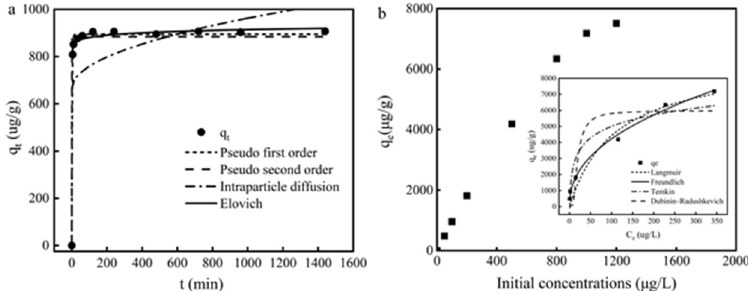
Figure 6. ( a ) Effects of the contact time and pseudo-first-order, pseudo-second-order, intraparticle diffusion, and Elovich kinetic models for the adsorption of Cd (II) ions onto Fe 3 O 4 @PB; ( b ) Effect of initial concentration of Cd (II); the insets are equilibrium adsorption data fitted by the Langmuir, Freundlich, Temkin, and Dubinin–Radushkevich models.